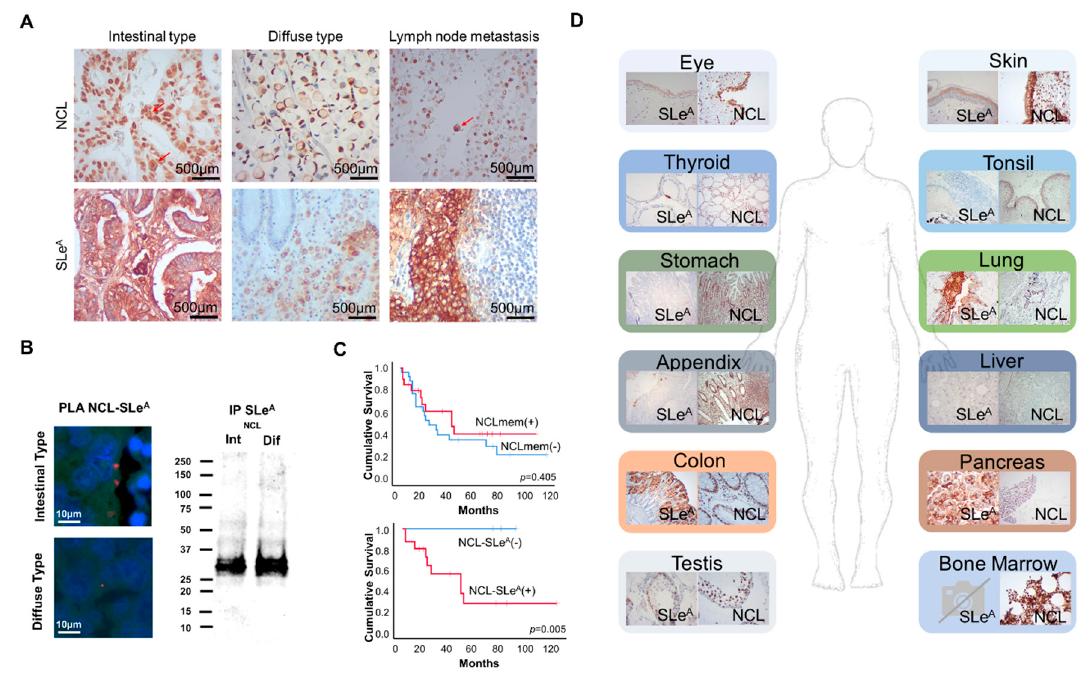
Figure 6. ( A ) SLeA and NCL expressions in intestinal and di ff use type GC as well as lymph node metastases (red arrows highlight NCLmem proteoforms). Both SLeA and NCL could be co-localized at the cell membrane of GC cells, reinforcing the notion of cell surface NCL-SLeA glycoforms. Of note, the nuclear subcellular location of NCL could also be observed in cancer cells. Similar observations were made in metastatic tissue. ( B ) Proximity ligation assay of SLeA and NCL (left panel) and Western blots (right panel) for NCL isolated by immunoprecipitation for SLeA. The red dots in PLA analysis suggest very close spatial proximity between NCL and SLeA. The blots from two histologically di ff erent tumors (intestinal and di ff use) show a major band at 37 kDa most likely corresponding to NCL-SLeA glycoforms. The blots also suggest the existence of vestigial proteoforms at higher molecular weights. Collectively, these findings support the existence of NCL-SLeA glycoforms at the cell surface. ( C ) Kaplan-Meier analysis of patients bearing tumors expressing NCL at the cellular membrane (NCLmem) and SLeA NCLmem (NCL-SLeA) glycoforms. The expression of NCLmem does not associate with worst prognosis ( p = 0.405) whereas NCL-SLeA significantly associated with decreased survival ( p = 0.05). These observations support the importance of targeting abnormal protein glycosylation towards clinically useful biomarkers. The p-values in survival analyses reflect the Breslow test. ( D ) Expression of SLeA and NCL in healthy human tissues of relevant organs. SLeA was found in the cytoplasm of exocrine pancreas cells and mildly detected at the cell membrane of goblet cells of the gastrointestinal tract, in upper layers of the corneal epithelium, rare thyroid parafollicular cells and pulmonary secretions. NCL was detected in the nucleus of most non-malignant cells. Membrane NCL was only observed in the epidermis and corneal epithelium, even though not in the same cell types expressing SLeA. These observations suggest that the conjugation of SLeA and NCL at the cell membrane is a rare event associated with cancer, holding cancer-specific targeting